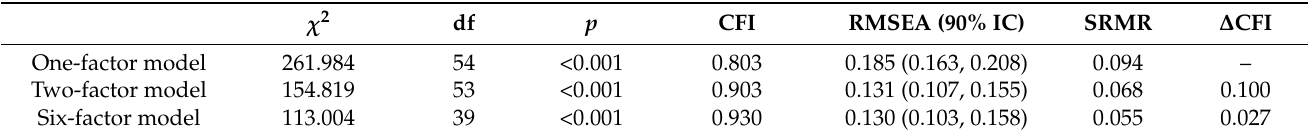
Table 3. Confirmatory Factor Analyses general